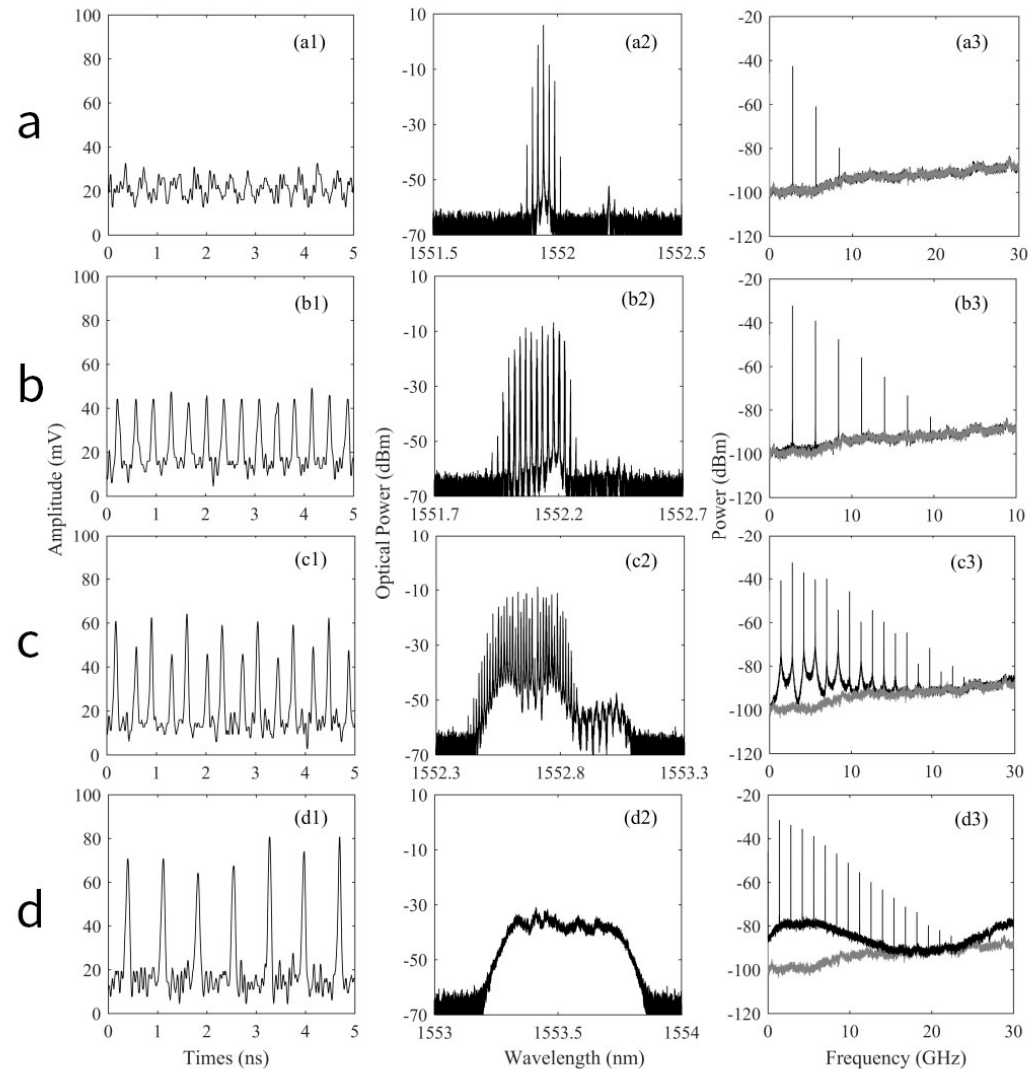
Figure 3. Time series (first column), optical spectra (second column), and power spectra (third column) of a current modulated 1550 nm VCSEL at I = 5.0 mA and f m = 2.8 GHz under di ff erent values of P m , where ( a ) P m = − 5.0 dBm, ( b ) P m = 7.0 dBm, ( c ) P m = 13.0 dBm, and ( d ) P m = 17.0 dBm. The gray curves in the power spectra denote the noise